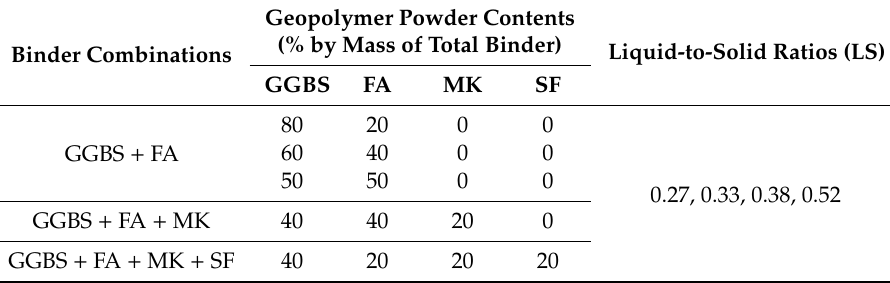
Table 3. Geopolymer grout